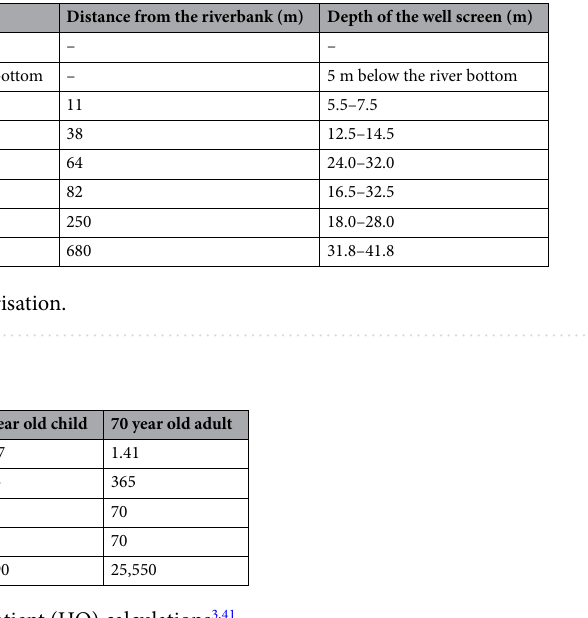
Table 2. Parameters for hazard quotient (HQ) calculations 3,41